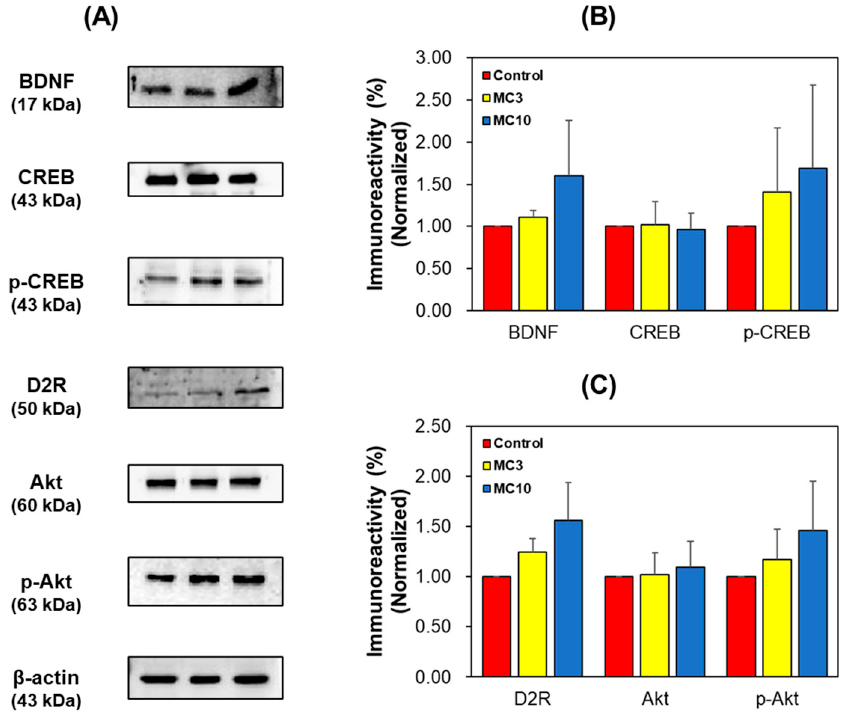
Figure 7. Western blotting of CREB, p-CREB, BDNF, Akt, p-Akt, and D2R in the SH-SY5Y cells. Western blots ( A ), and levels of immunoreactivities for BDNF, CREB, and p-CREB ( B) and for D2R, Akt, and pAkt ( C ). C, control; MC3 and MC10, doses of the compound MC (scopolamine + 3 and 10 μ M of MC, respectively). Data are presented as mean ± SEM.